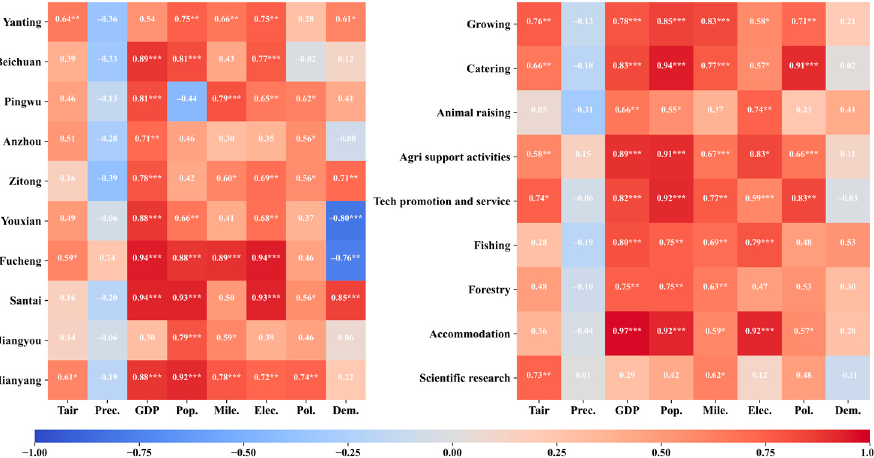
Figure 9. Correlation coefficients of the dynamic indicator of rural entrepreneurship evolution in different sub-administrative areas ( left panel) and industries ( right panel) Mianyang from 2011 to 2020 (* indicates p value < 0.1, ** indicates p value < 0.05, and *** indicates p value < 0.01).